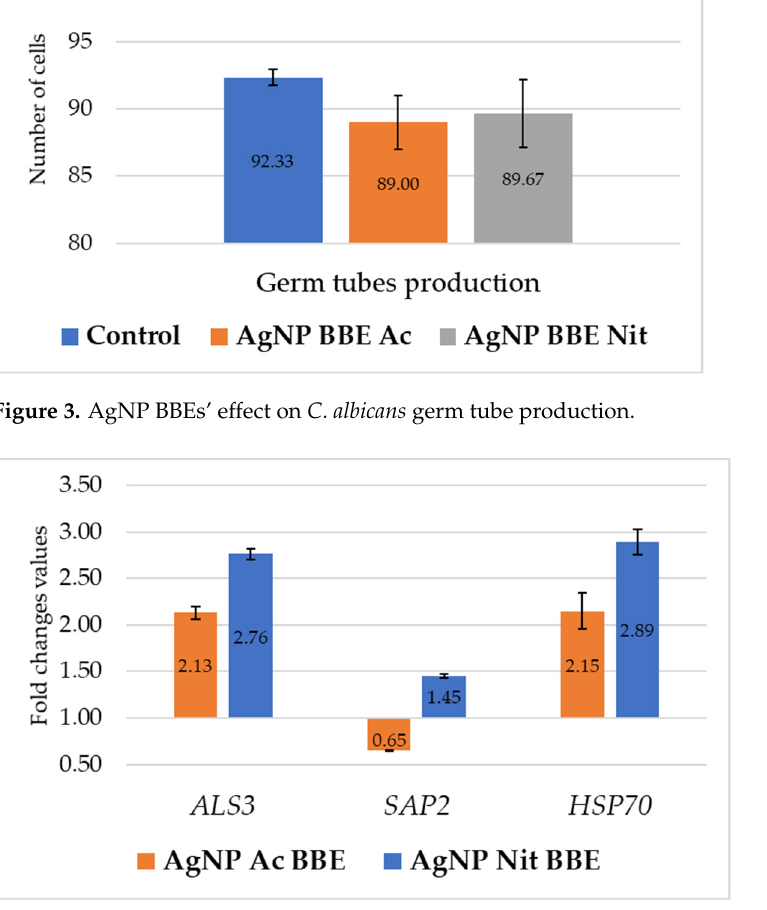
Figure 3. AgNP BBEs’ effect on C. albicans germ tube production.